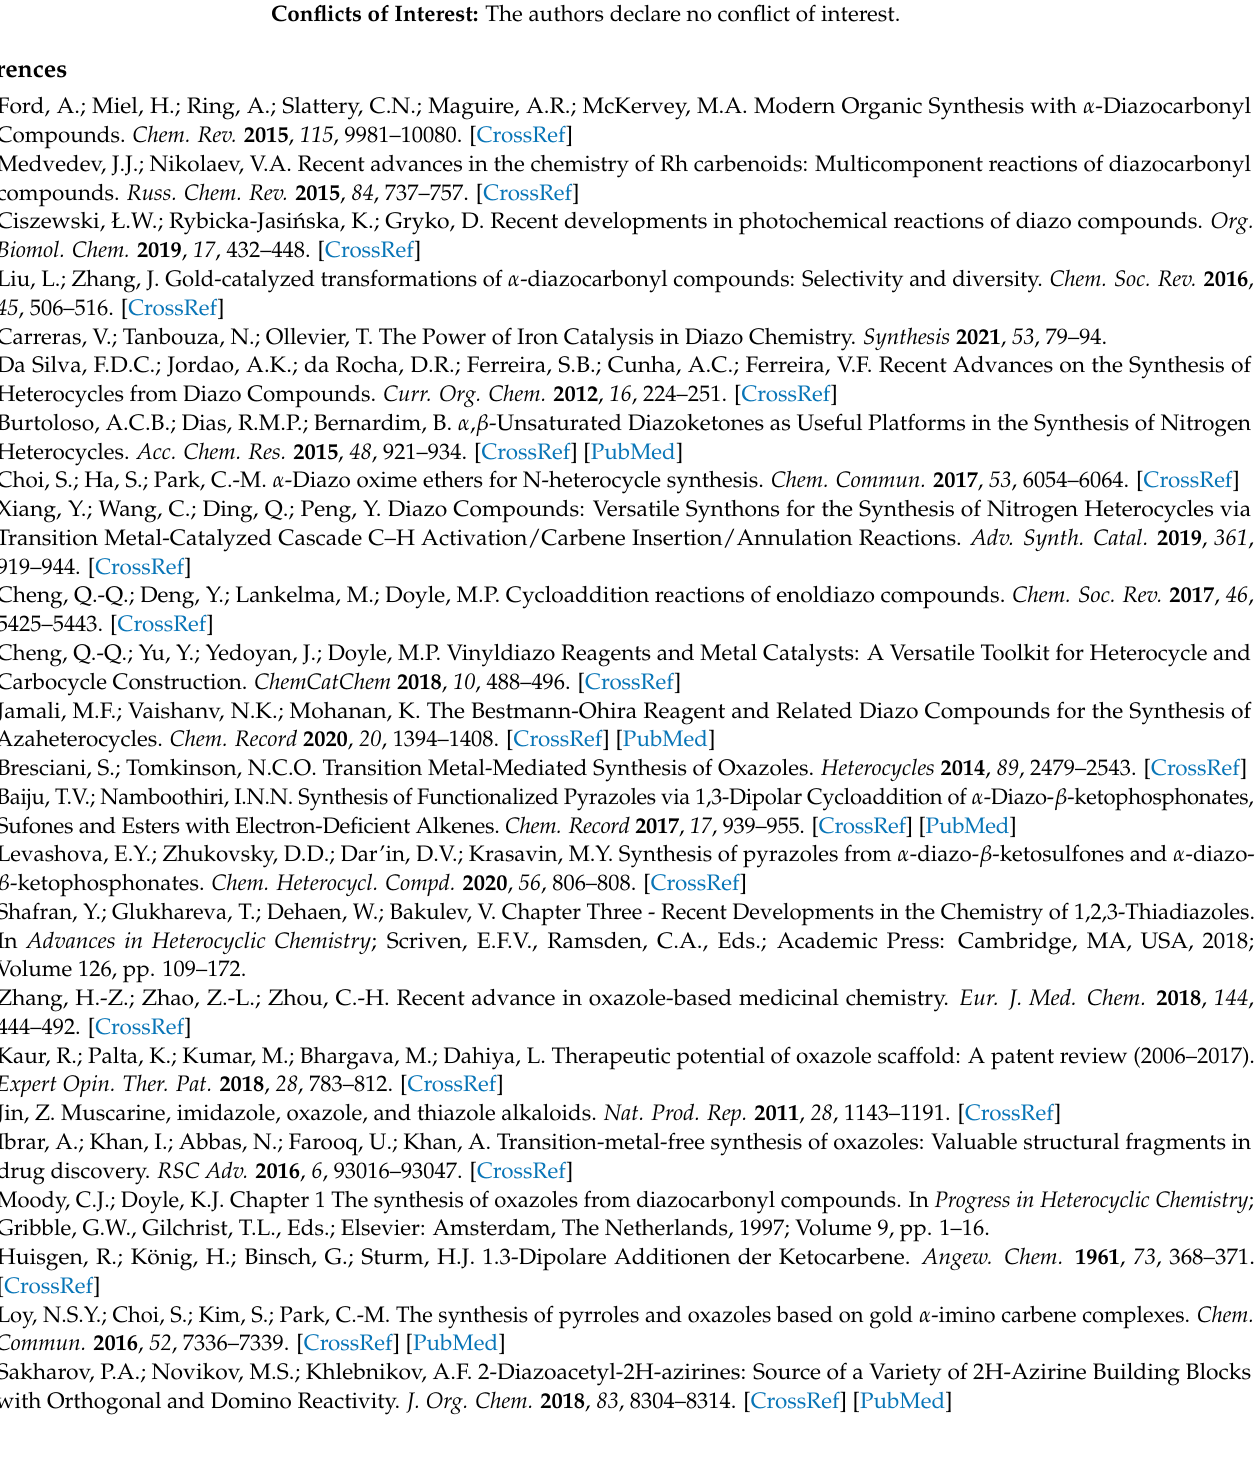
figure drawing, A.B.; writing—original draft preparation, A.B.; writing—review and editing, D.D., G.K. and M.K. All authors have read and agreed to the published version of the manuscript. Funding: This research was supported by the Russian Science Foundation (project grant 20-13-00024). Conflicts of Interest: The authors declare no conflict of